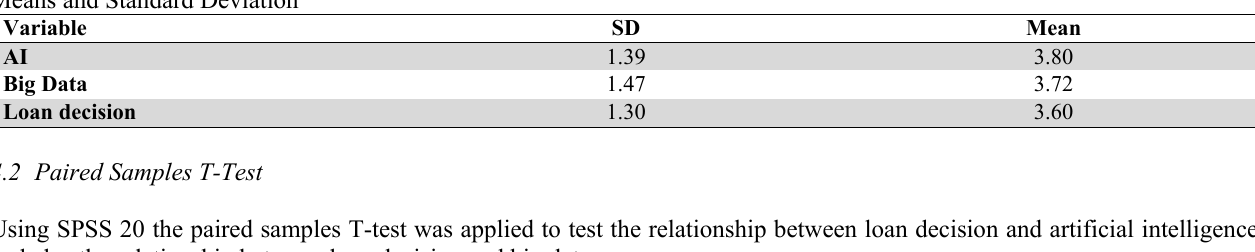
Paired Samples T-test AI and Loan Decision Variable Mean SD T Loan Decision 3.60 1.30 Artificial Intelligence